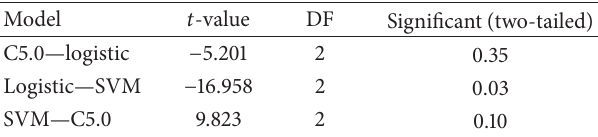
Table 7: Paired-samples 𝑡